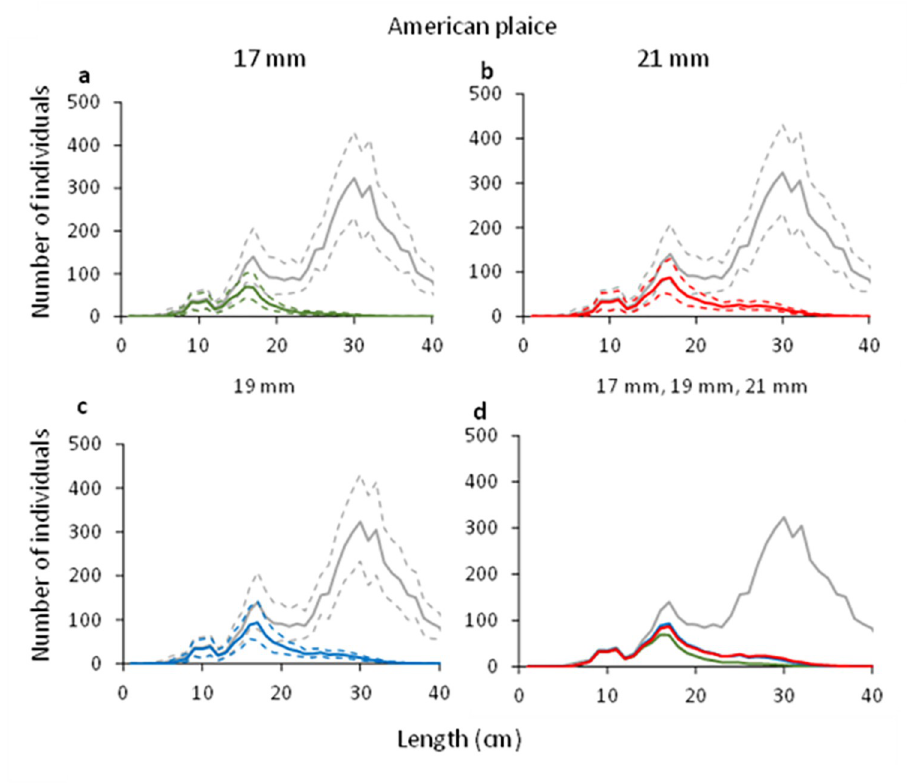
Fig 10. Number of retained American plaice and the entry population (grey line) when using grid with 17 mm (green), 19 mm (blue) and 21 mm (red) bar spacing. Stippled lines represent the 95% CI’s.